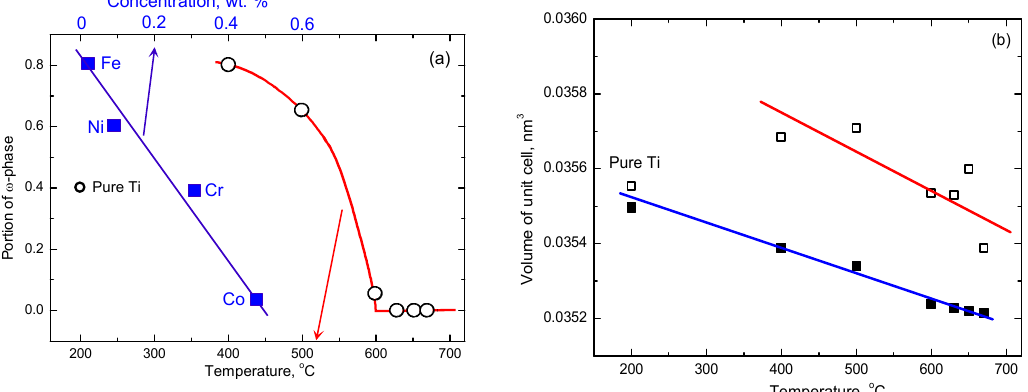
Figure 2. X-ray diffraction patterns of Ti–3wt.% Ni (upper curves), Ti–2wt.% Cr (middle curves), and Ti–4wt.% Co (lower curves) annealed at 600 °С, 2774 h ( a ) before HPT and ( b ) after HPT.